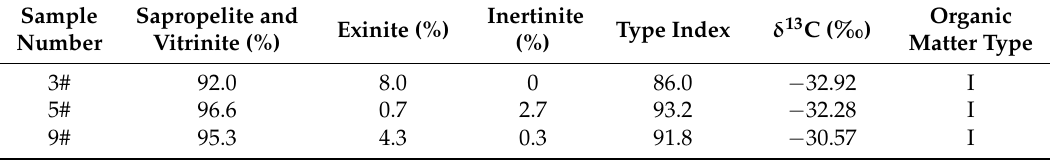
Table 2. Maceral composition of kerogen of the Niutitang Formation shales in northwestern Hunan.